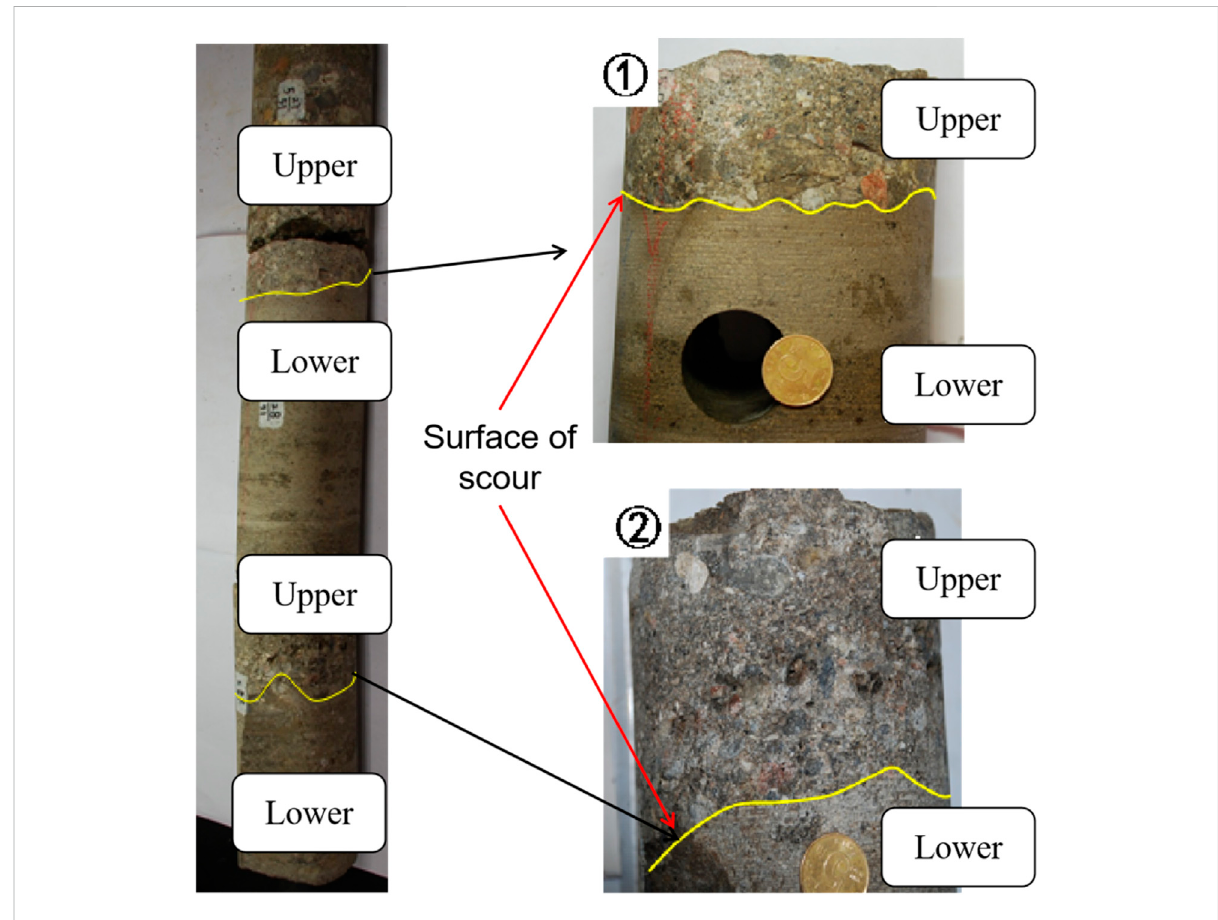
FIGURE 3 The core of underwater distributary channel in Well